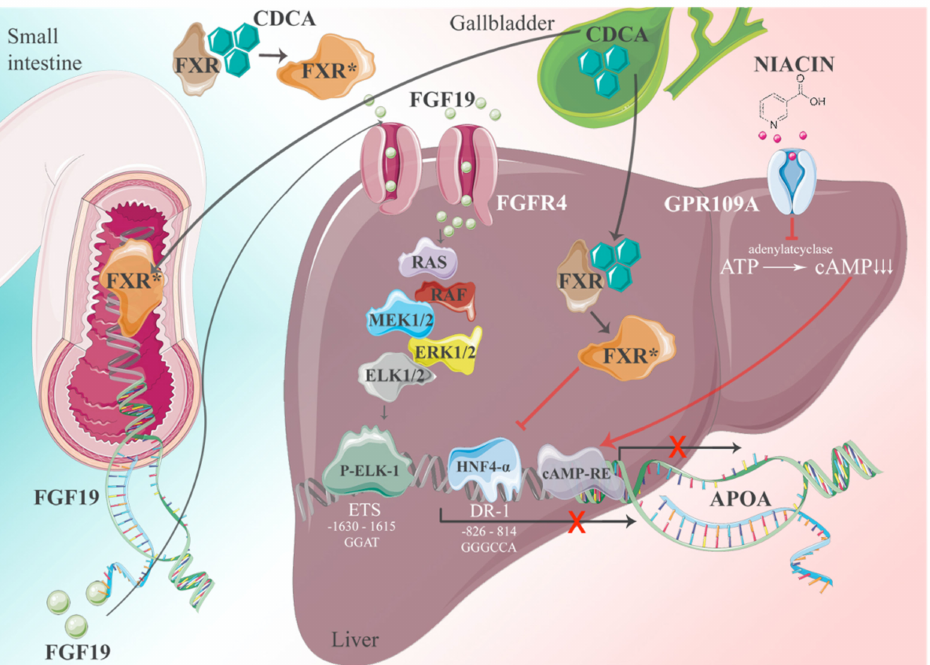
Figure 6. The interference of apo(a) transcription by FXR ligands. The apo(a) transcription is driven by numerous transcription factors. The most important one is probably HNF4 α which binds to its response element at − 826 to − 814 relative to the transcription initiation site. There are two pathways whereby FXR-ligands downregulate the apo(a) expression, one direct one and the other by FGF-19 binding to the FGF4 receptor. There is also a cAMP response element found in the apo(a) promoter that might be inhibited by nicotinic acid.The * indicates activated FXR